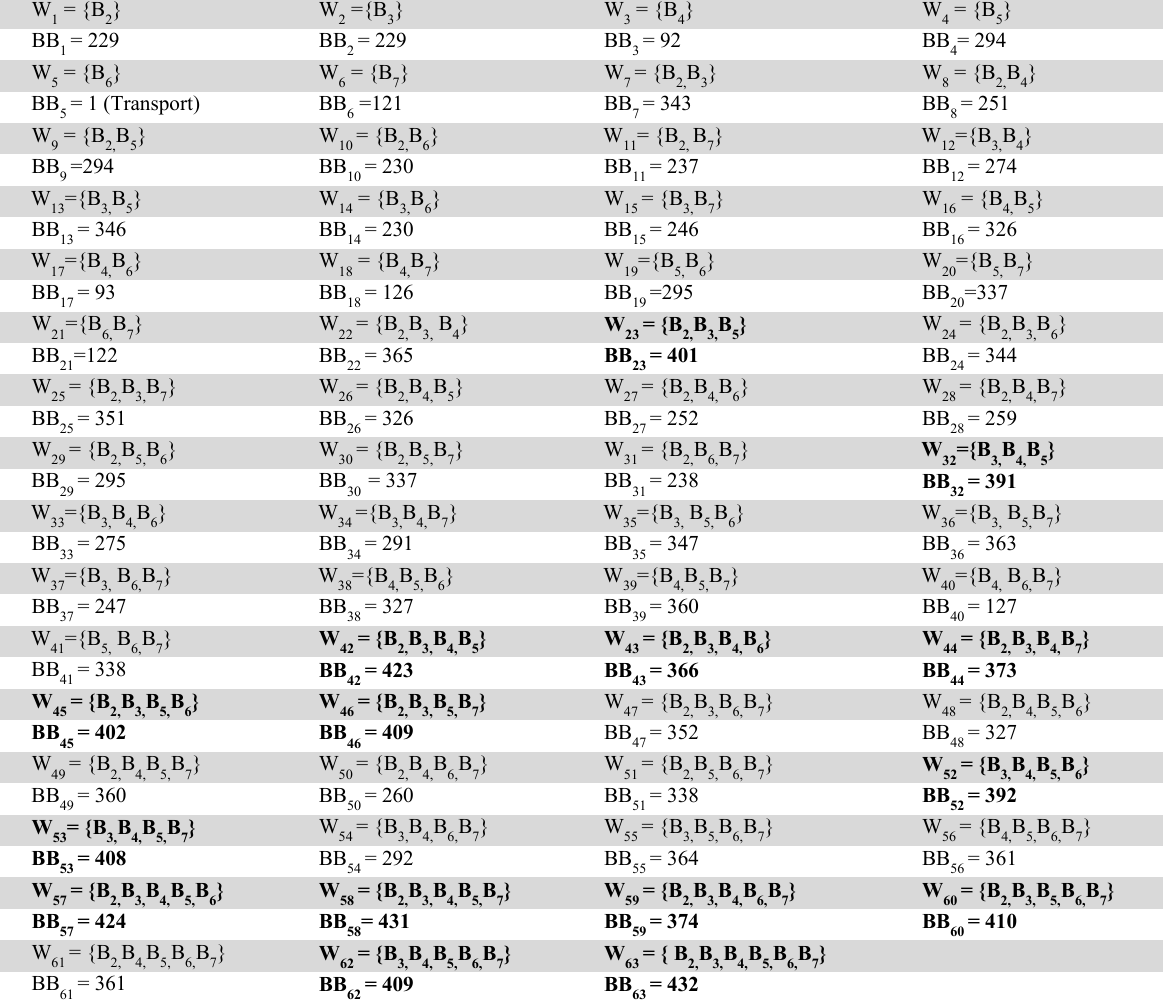
W j Buffer cluster sets and BB j values for each buffer cluster